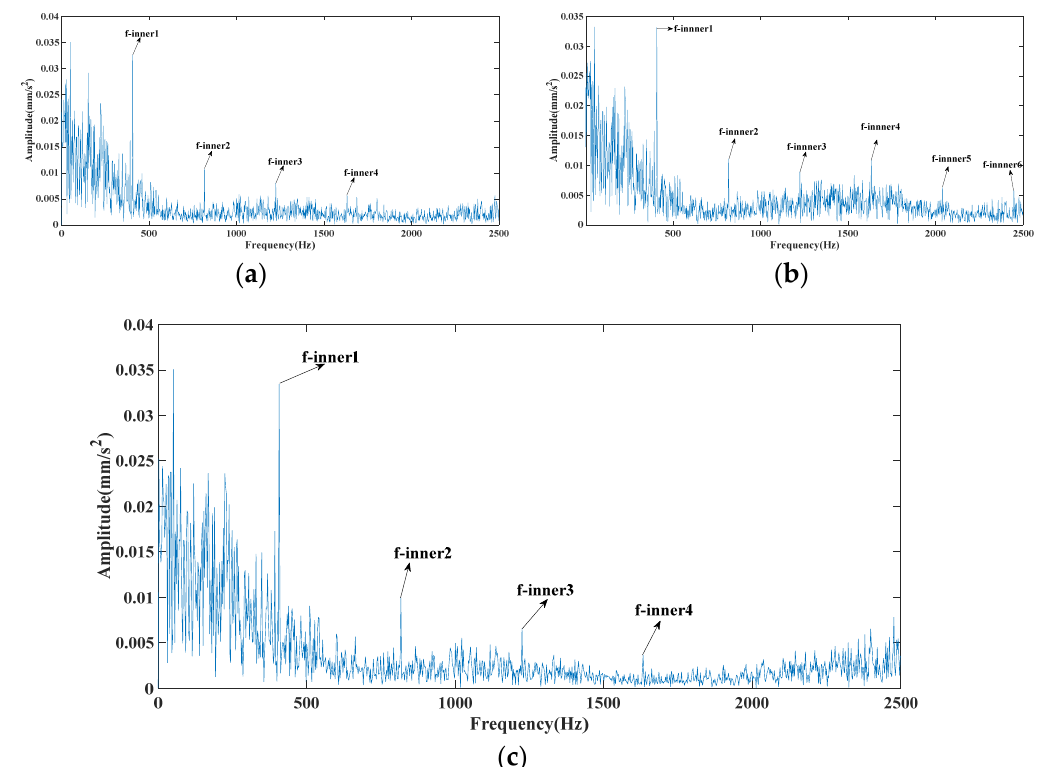
Figure 12. Comparison chart of the envelope spectrum results of three methods: CEEMDAN, ICEITDAN, and ITD. ( a ) ITD, ( b ) ICEITDAN, and ( c ) CEEMDAN. Table 7. PMGI values of different